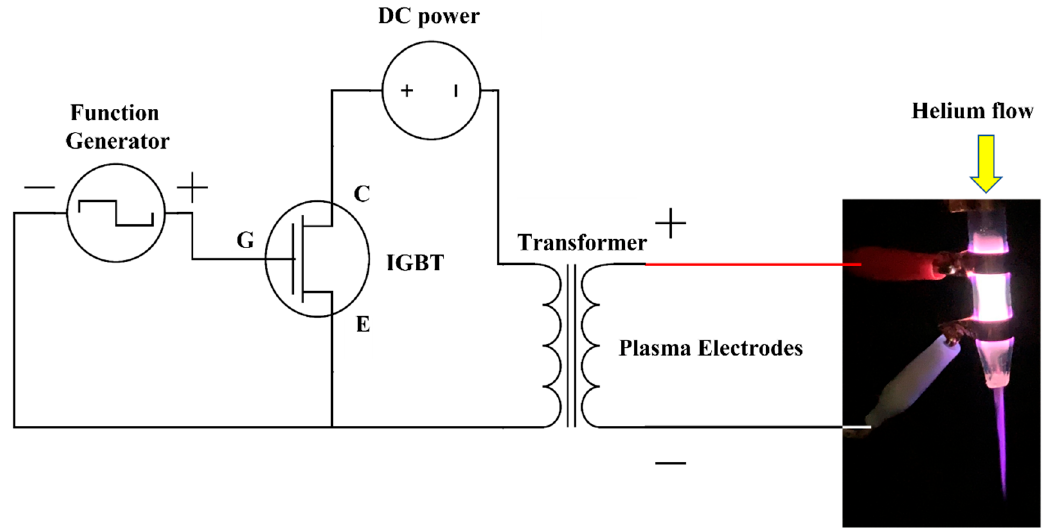
Figure 1. Schematic illustration of double–ring electrodes’ APPJ source. IGBT: insulated–gate bipo- lar transistor (IGBT). Oscillating high voltage was generated between two copper electrodes. Throughout this whole study, “plasma plume” just means the violet plasma formed below the noz- zle, it does not mean the white lighting area between two